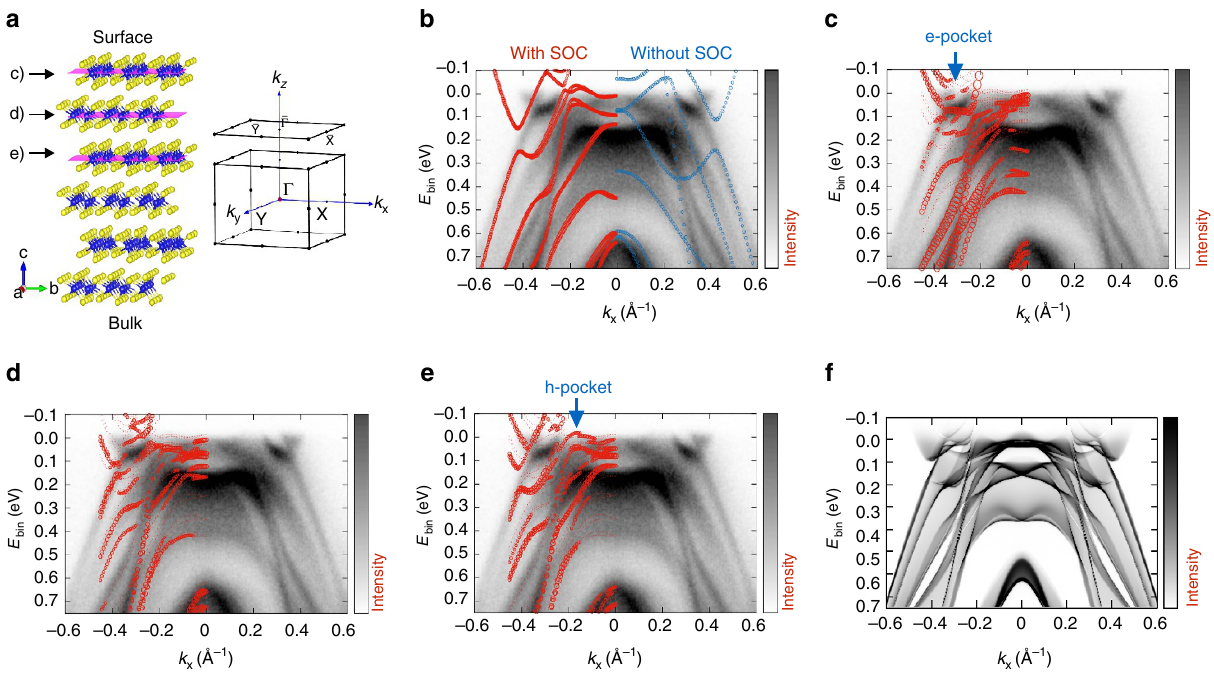
Figure 2 | Evolution of band structure with number of layers. ( a ) Crystal structure of WTe 2 with the bulk and surface Brillouin zones on the right. On the left, the slab model used in the theoretical calculations, consisting of six Te–W–Te layers; each layer is formed by hexagonally packed W sandwiched between two Te layers. ( b – e ) ARPES measurements ( hv ¼ 68eV, T ¼ 77K) of the electronic structure along the G X high symmetry direction (along the W chains); ( b ) bulk electronic structures as calculated with SOC (red bands at negative momenta) and without SOC (blue bands at positive momenta); ( c ) theoretical bands projected on the topmost WTe 2 planes; ( d , e ) theoretical bands projected on second and third plane, respectively. In c , e , blue arrows mark the positions of the theoretical electron and hole pockets, respectively. In b , e , the size of the circles is proportional to the weight of the layer-resolved orbital character, calculated as the sum of the orbital characters of all the atoms belonging to the respective layer. ( f ) The theoretical surface spectral function A ( k , E theory (DFT) with (red bands on the left) and without (blue bands on the right) SOC, along the reciprocal space line X G X.